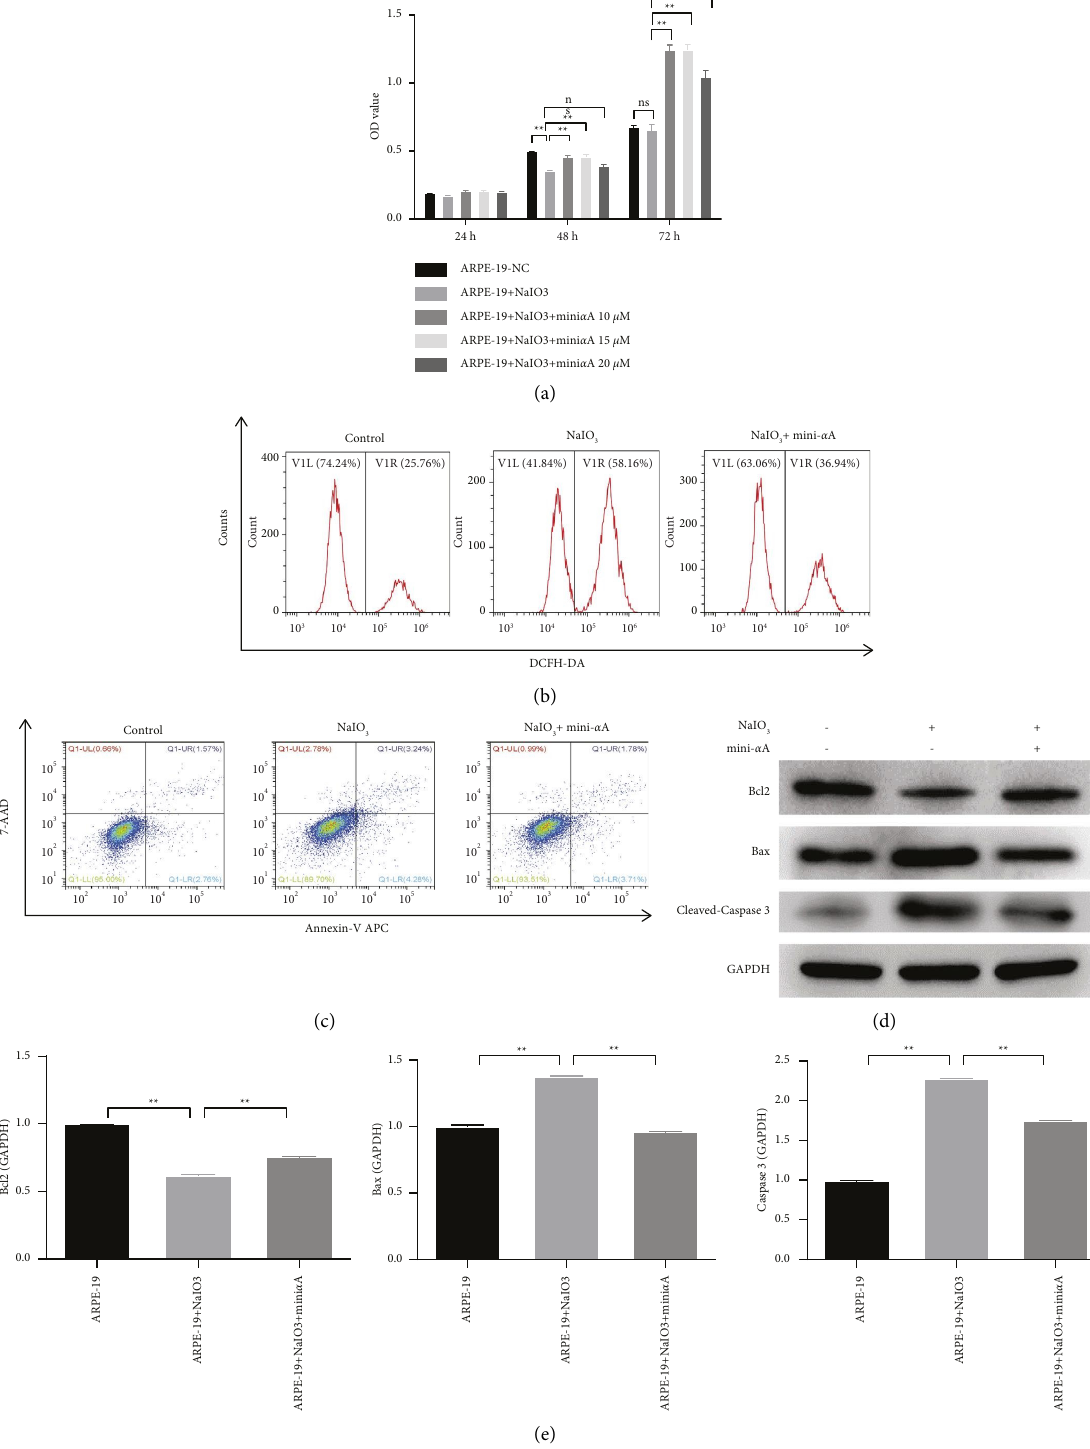
Figure 1: Antiapoptotic efect of mini- α A on oxidative stress-induced apoptosis of ARPE-19 cells. ARPE-19 cells were treated with NaIO establish a retinal degeneration model, and mini- α A was used for treatment; (a) cell viability was examined using CKK-8. (b) ROS level was detected using reactive oxygen species assay kit. (c) Apoptosis was detected using annexin V/7-AAD double staining kit. (d) Te expression of Bcl2, Bax, and cleaved caspase-3 was measured using western blotting. (e) Quantitative analysis of protein in (d); ns, not signifcant; ∗∗ P < 0 .